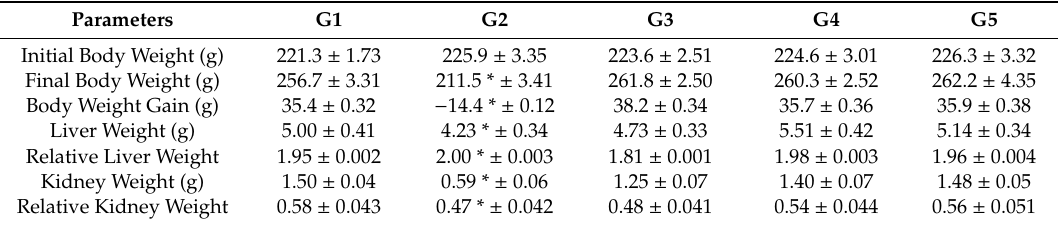
Table 1. Ameliorating effects of Nano-CUR on body weight, body weight gain, liver weight, kidney weight, relative liver weight, and relative kidney weights.